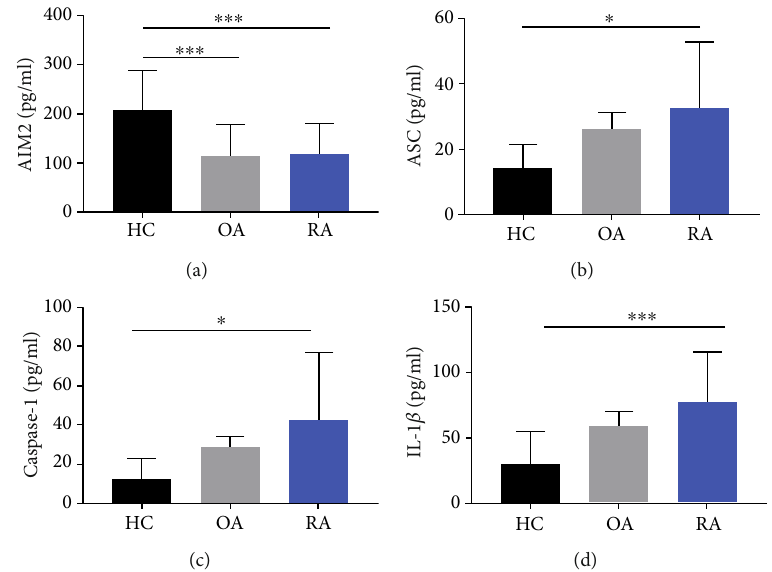
Figure 1: The di ff erences in AIM2 pathway-related molecules in sera among HCs, OA, and RA patients. The HCs expressed obviously higher level of AIM2 than OA and RA patients (a), and ASC, caspase-1, and IL-1 β expressed obviously higher in RA patients than HCs (b – d). No statistical di ff erences of these molecules between OA and RA (a – d). ∗ p < 0 : 05 , ∗∗∗ p < 0 : 001 , and ∗∗∗∗ p < 0 : 0001